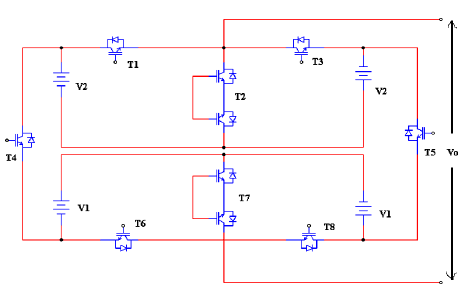
Figure 29. Bidirectional switch MLI circuit.